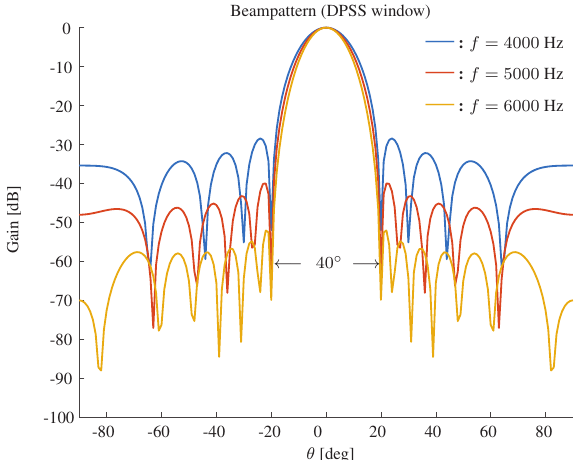
Figure 4. Constant beamwidth beampattern using a DPSS window. The beamwidth is fixed to 40 ◦ , M = 11, δ = 3.5